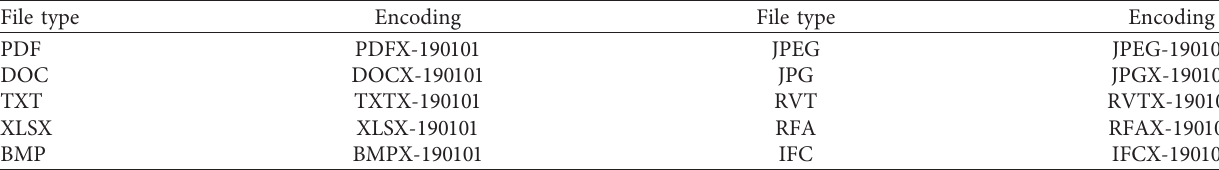
Table 6: Encoding of delivery-related files.